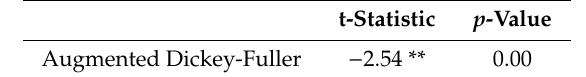
Table 4. Kao residual cointegration test (ADF test).